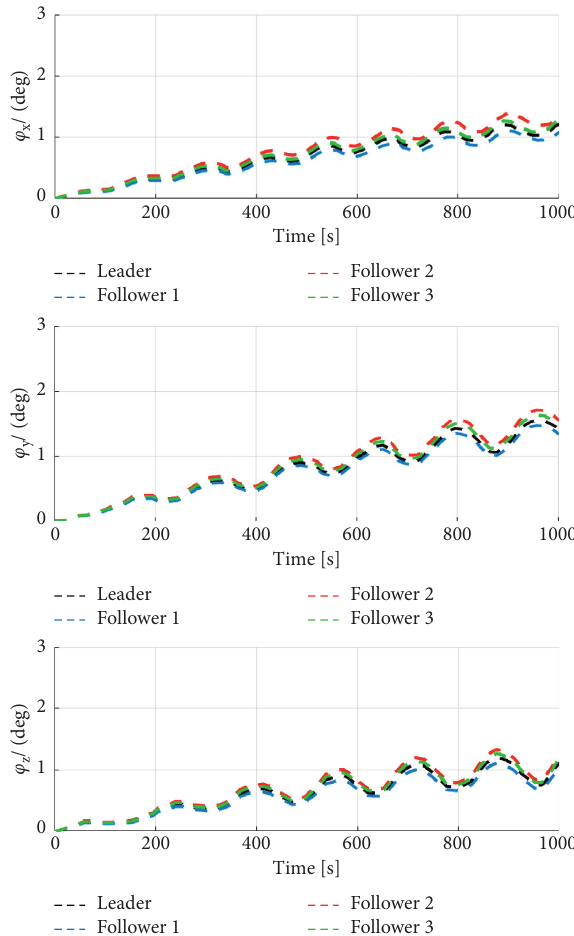
Figure 10: Attitude curve of the strap-down inertial navigation